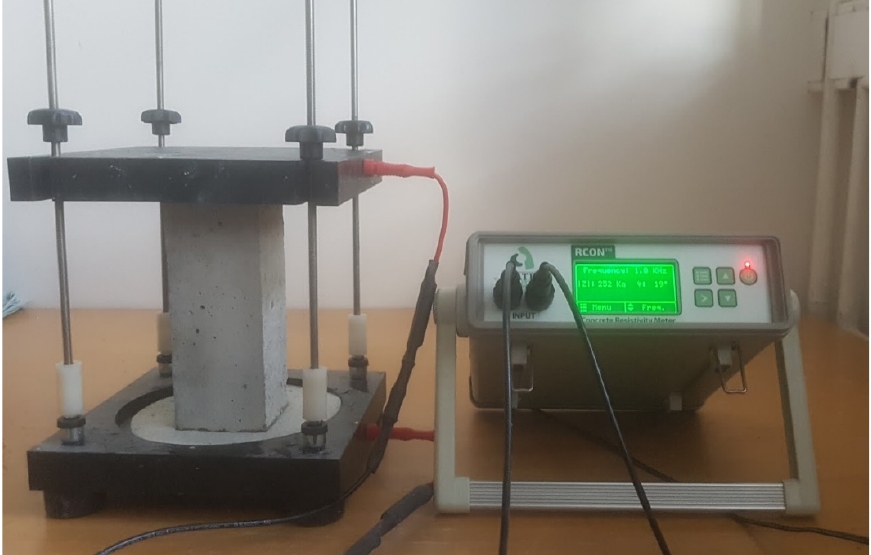
Figure 1. Prismatic sample placed in the RCON instrument.